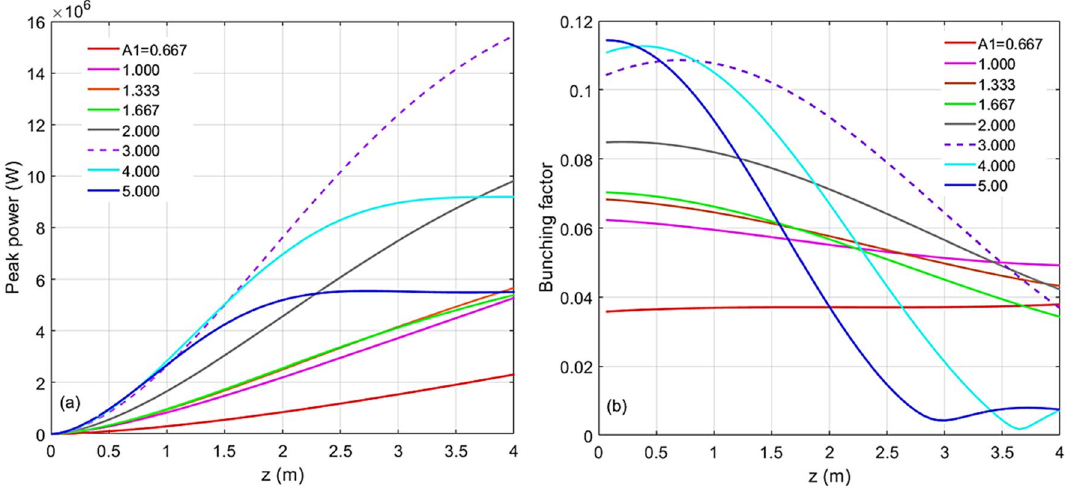
Figure 4. For the case of harmonic 67, the energy modulation of stage 1 is scanned with the values of 0.667 (red), 1.000 (magenta), 1.333 (orange), 1.667 (green), 2.000 (grey), 3.000 (purple), 4.000 (cyan), and 5.000 (blue). ( a ) Peak power versus undulator position. ( b ) Bunching factor versus undulator